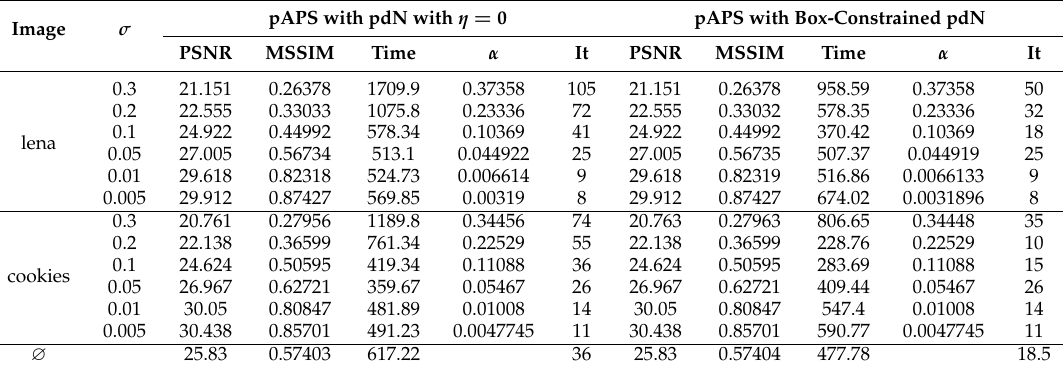
Table 11. PSNR- and MSSIM-values for the application inpainting via